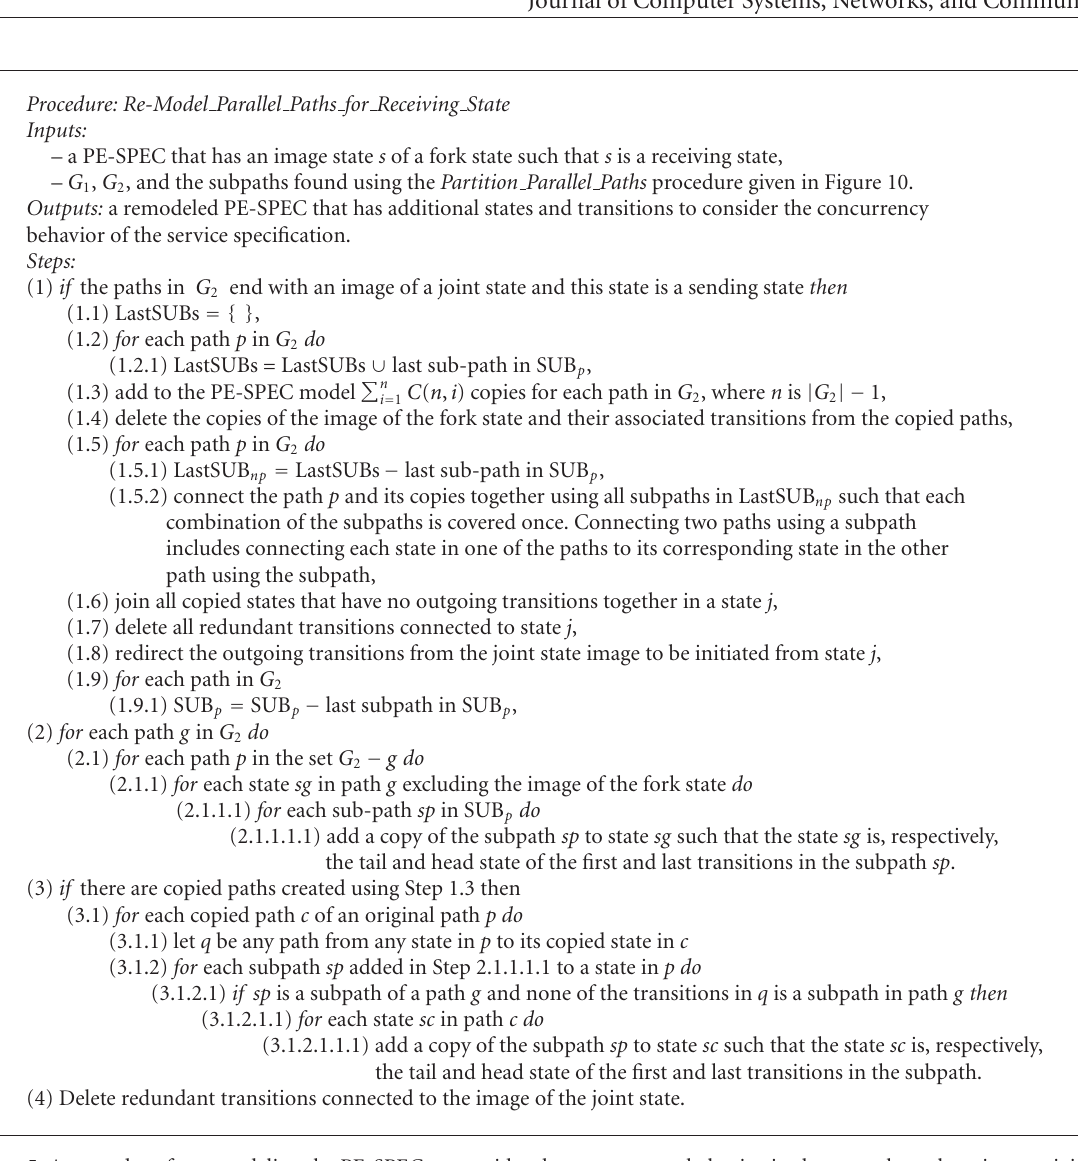
Algorithm 5: A procedure for remodeling the PE-SPEC to consider the concurrency behavior in the case where there is a receiving image of fork state.